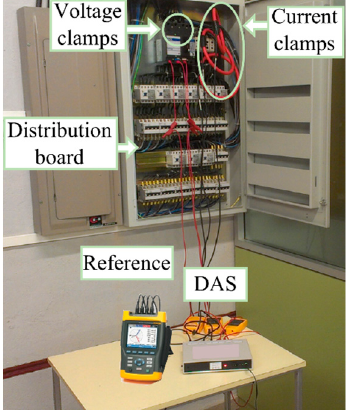
Figure 4. Distribution board for the validation test.